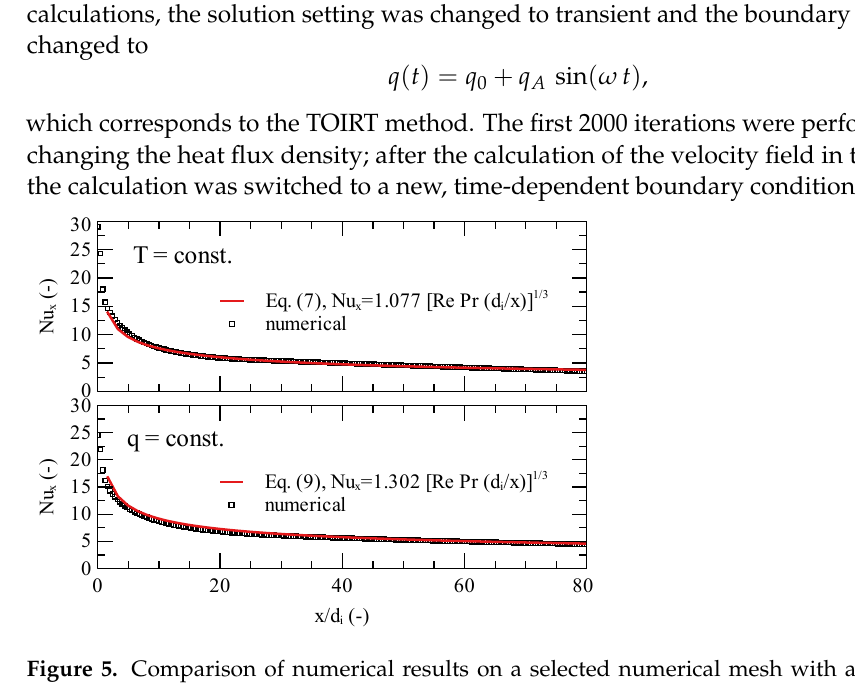
Figure 5. Comparison of numerical results on a selected numerical mesh with an analytical so- lution for two basic boundary conditions. The comparison was prepared for water (Pr = 6.99), ω = 0.1047rad/s, Re = 497 ( ¯ u = 0.5 m/s) and for a hydrodynamically developed flow profile (setting the UDF function at the inlet).